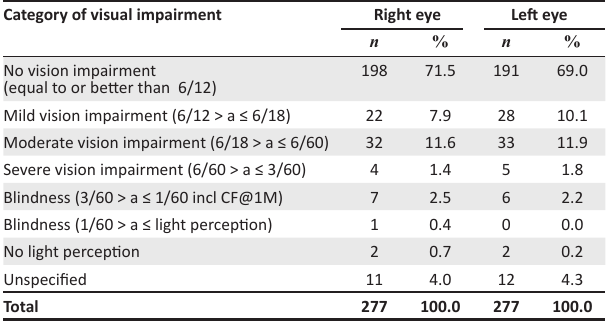
TABLE 3: Contribution of refractive errors to visual impairment.